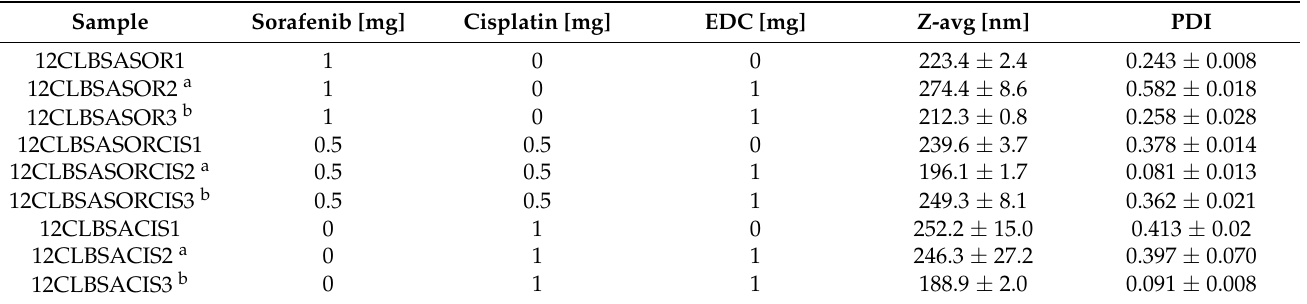
Table 2. Encapsulation of the active agents, using 1:5 oil-in-water ratio, 1% PVA emulsifier, and 0.5 mg BSA.